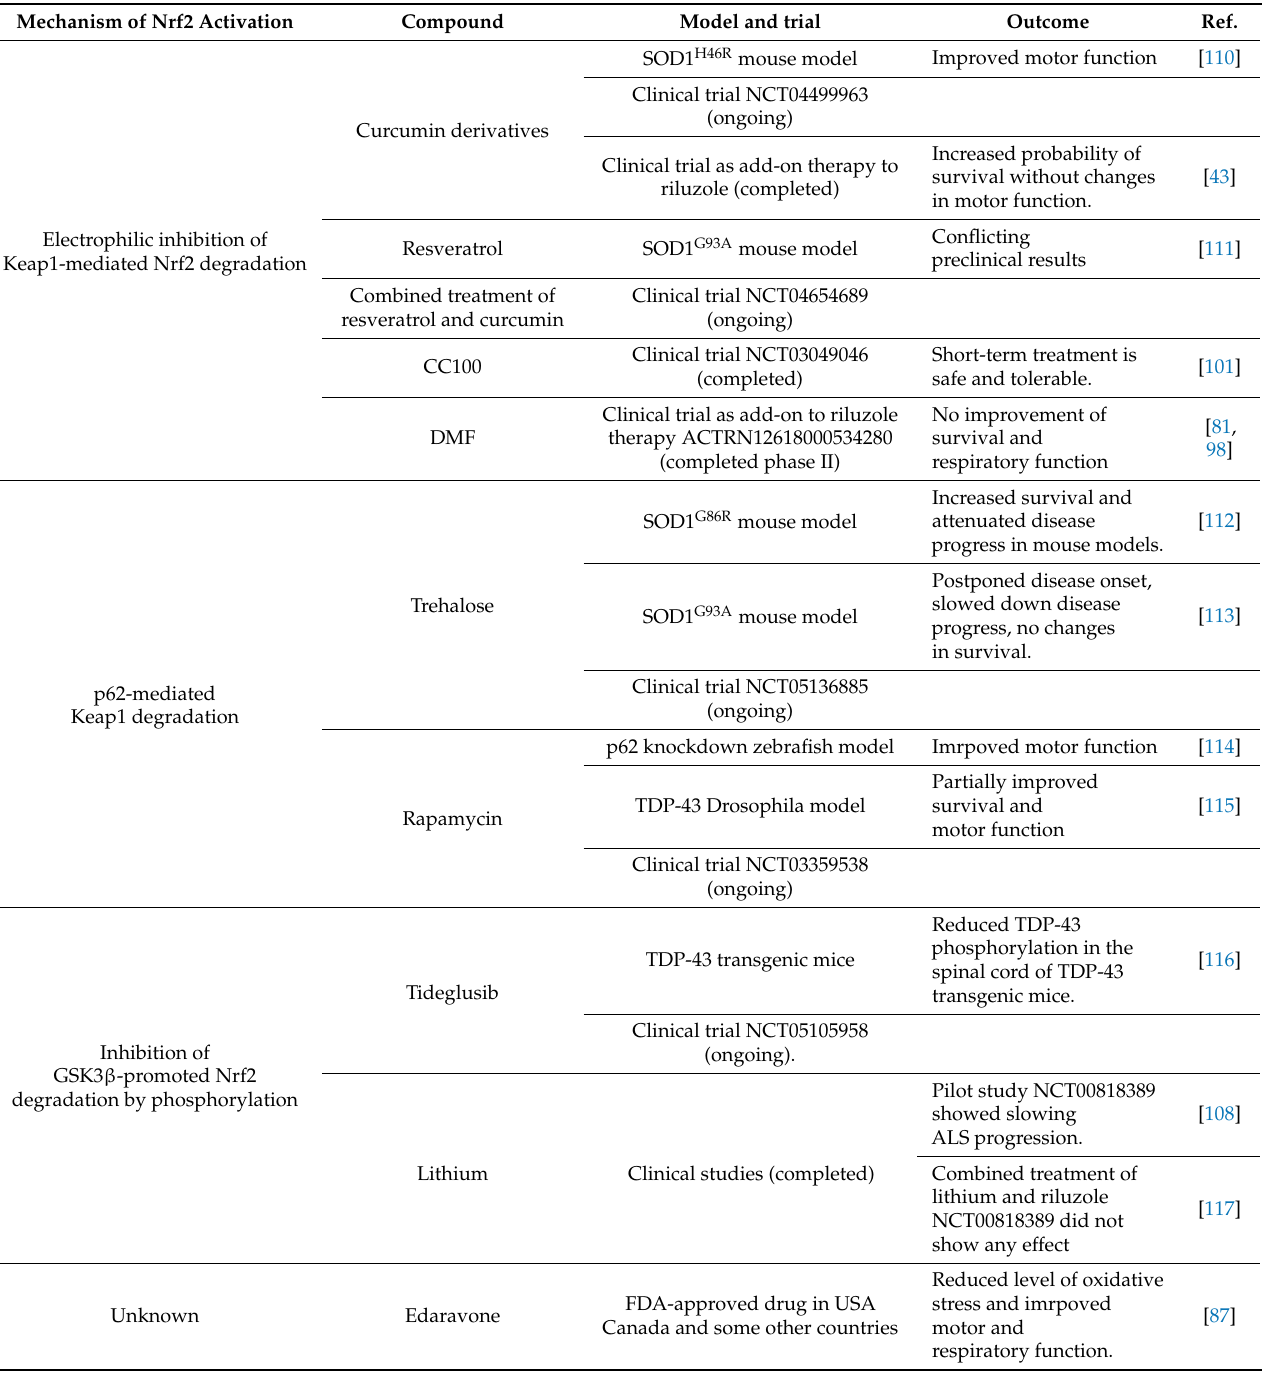
Table 2. Preclinical and clinical studies of promising